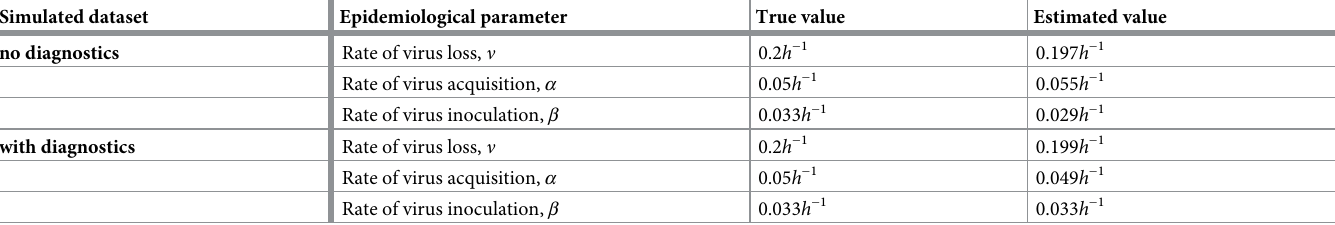
Table 2. Estimates of epidemiological parameters from a simulated access period experiment.